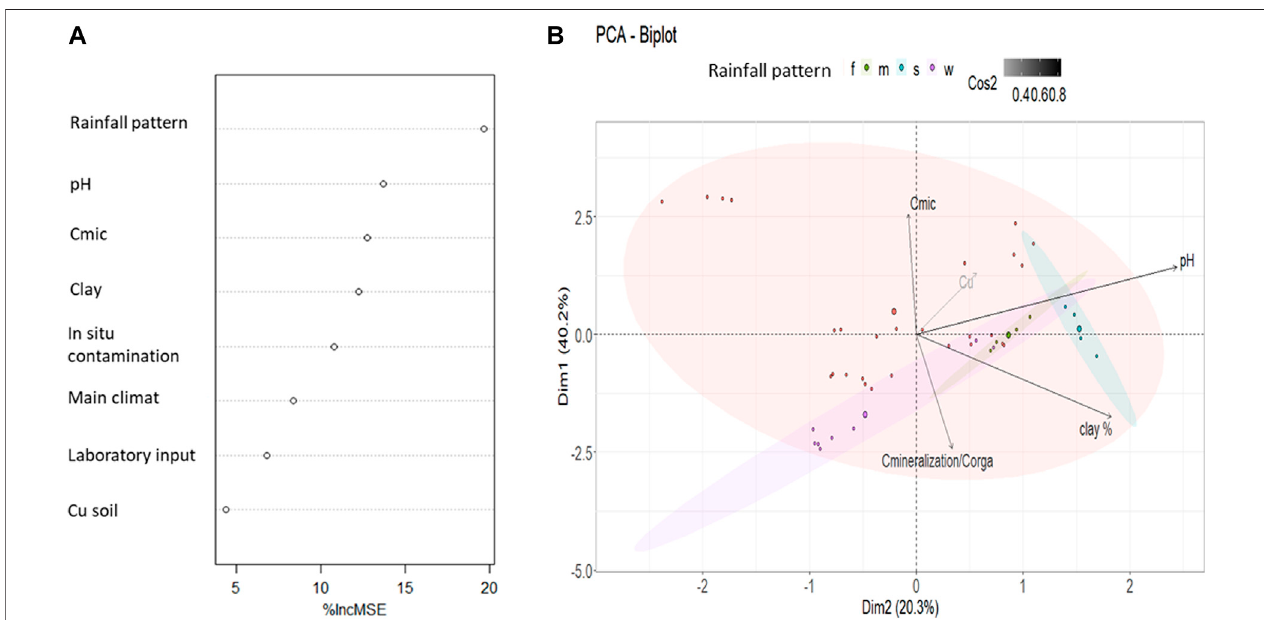
FIGURE 1 | Analytical statistic description of the 43 data with all recorded variables set by two statistical approaches (A) Random Forest analysis with the % of increase in mean standard deviation (%IncMSE) due to each variable for soil C mineralization per soil organic carbon (B) PCA with the 2 fi rst dimensions contributing to 60.5%ofvarianceinthedataset.QualityofrepresentationthroughPCAconstructionofquantitativevariables(axescomponent)arerepresentedthroughthecolorofthe arrow (cos2). Rainfall pattern is illustrated with the color of the data point, ellipse are the 95% con fi dence interval of groups representation in the PCA space estimation. Cmic is expressed in g per kg of soil, clay in percentage of soil, soil Cu in mg of Cu per kg of soil and C mineralization in mg of C-CO 2 per g of soil